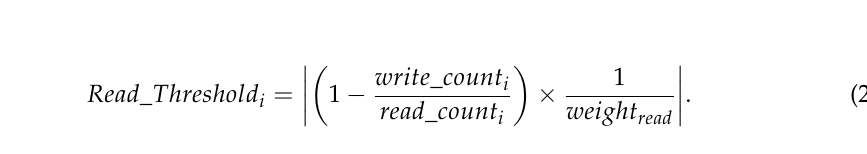
Table 2. Description of parameters for the analysis of the page access tendency. Parameter